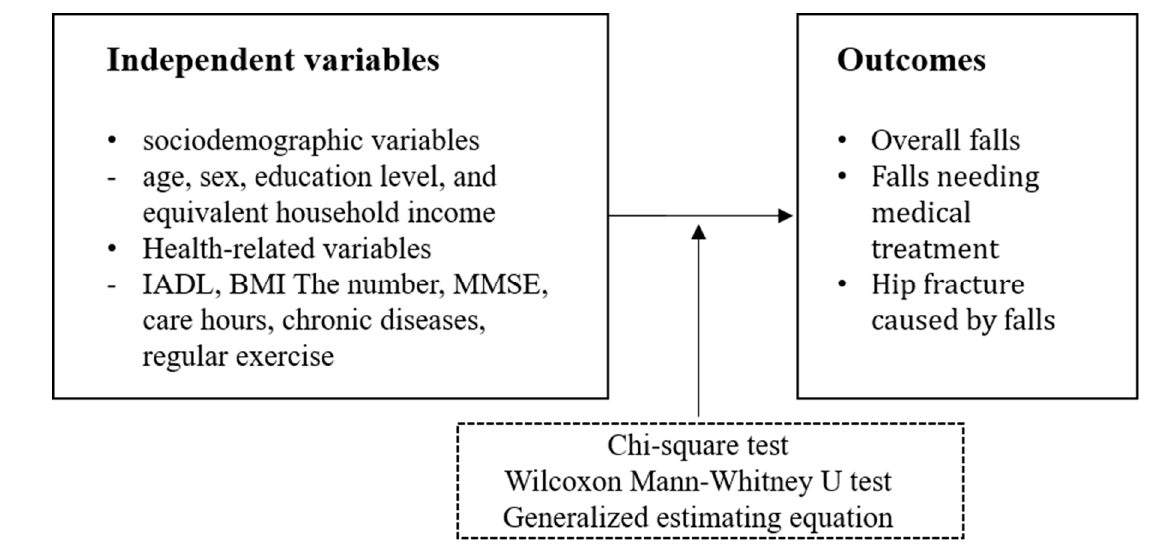
Figure 2. Variables and Statistics.